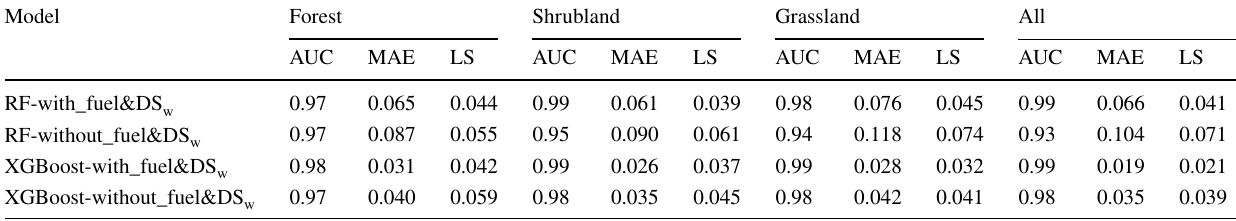
Table 2 Quantitative metrics of area under the receiver